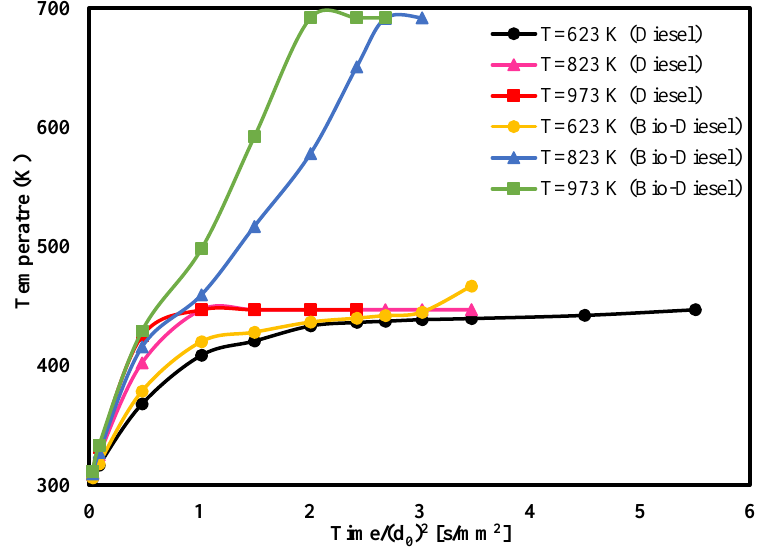
Figure 6. Effect of ambient gas temperature on the evaporation of a 20-micron droplet. Figure 6. E ff ect of ambient gas temperature on the evaporation of a 20-micron